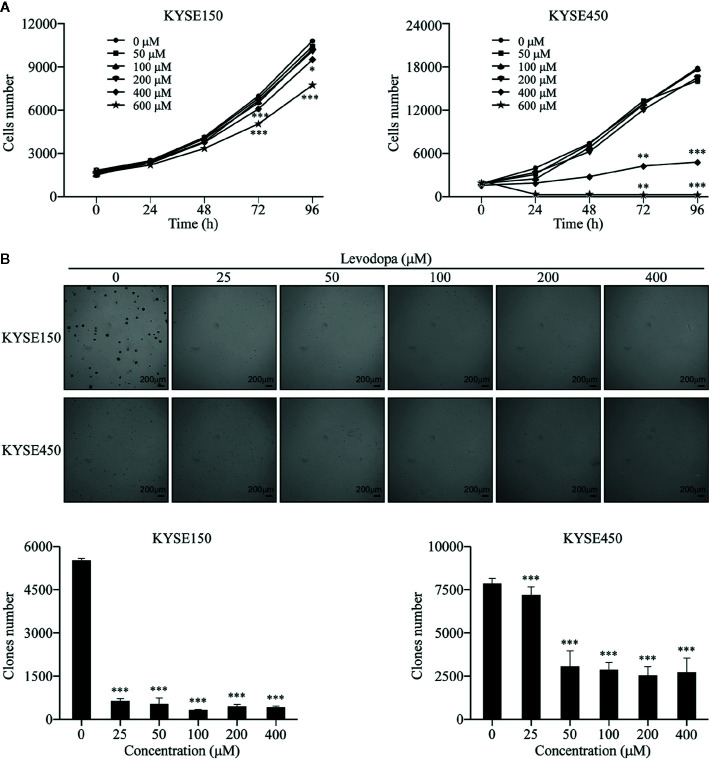
Levodopa inhibits the growth of ESCC cells. (A) KYSE150 and KYSE450 cells were treated with levodopa (0, 50, 100, 200, 400, and 600 μM) for 0, 24, 48, 72, and 96 h and evaluated using DAPI staining. (B) KYSE150 and KYSE450 cells were treated with levodopa (0, 25, 50, 100, 200, and 400 μM) for 2 wk. The asterisks indicate a significant decreases in proliferation and clone formation ability compared to that of the control (*P < 0.05, **P < 0.01, and ***P < 0.001). Values are expressed as mean ± SD (n = 3). ANOVA testing was performed; ***P < 0.001 vs. other group.